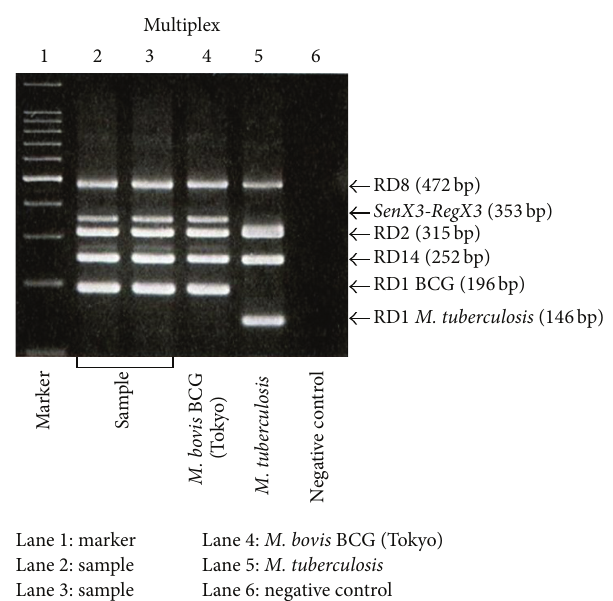
Figure 4: M. bovis was identified using multiplex polymerase chain